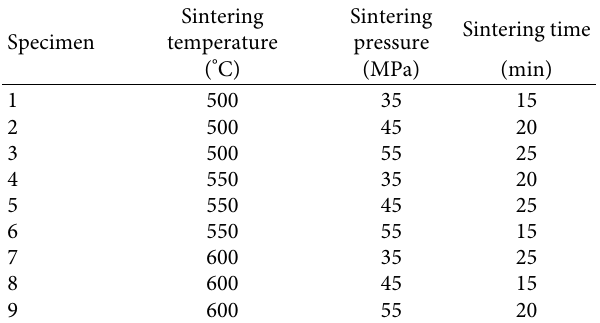
Table 1: Design of Taguchi L orthogonal